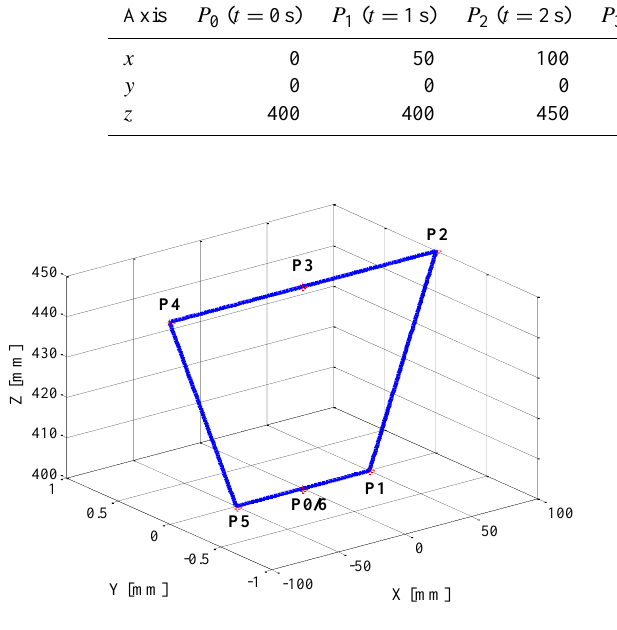
Figure 6. A prescribed input motion for experimental test. 4 Experimental test results